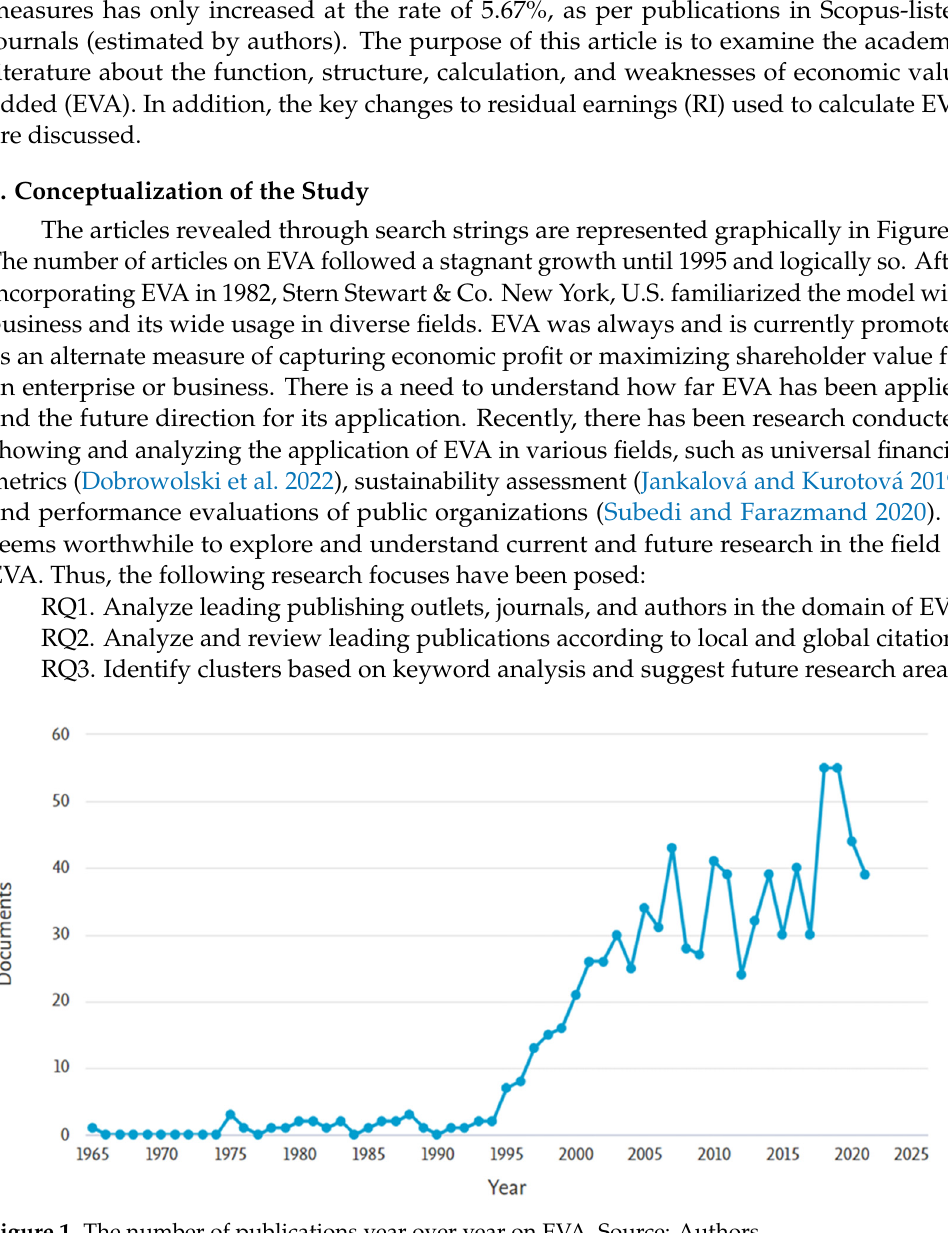
Figure 1. The number of publications year over year on EVA. Source: Authors.